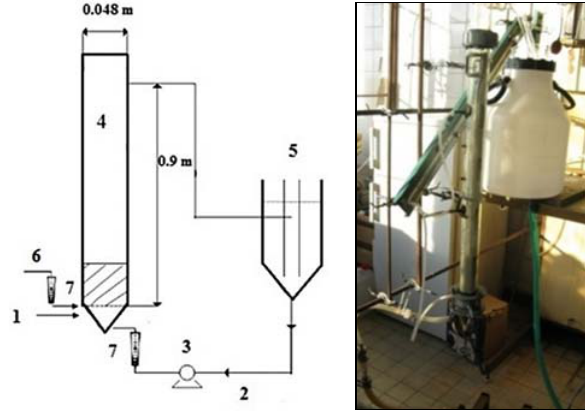
Figure 1. Scheme of lab-scale equipment of FBRR. (1– treated water inlet, 2 – external recirculation, 3 – pump, 4 – reactor with fluidised bed, 5 – settling and storage tank, 6 – inlet of